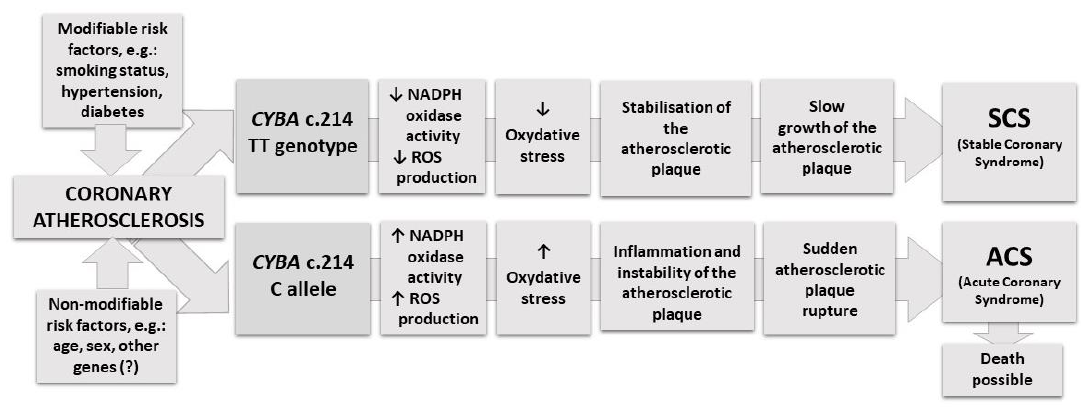
Figure 2. Schematic illustration of hypothesis of how the CYBA c.214C > T polymorphism might modulate plaque stability and influence the course of coronary atherosclerosis.